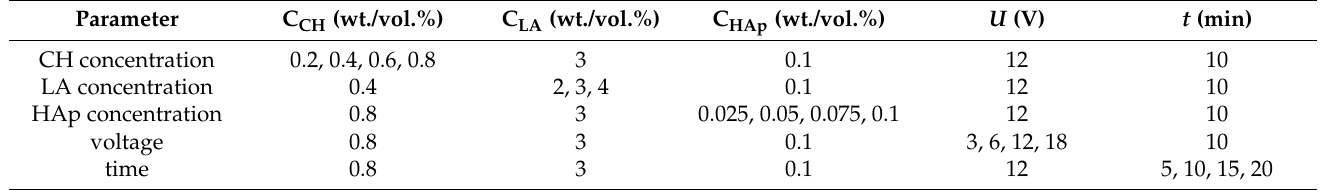
Table 2. The studied parameters influencing deposition from chitosan (CH)–hydroxyapatite (HAp) solution. LA, lactic acid.